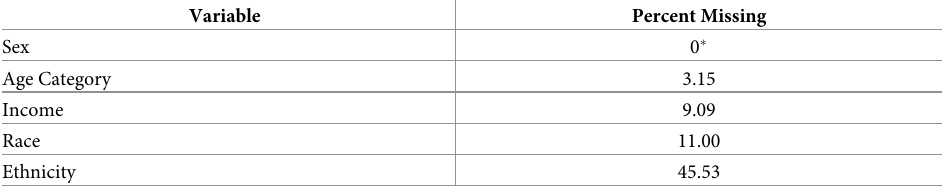
Table 2. Percent of missing values, King County, Washington anti-SARS-CoV-2 seroprevalence survey, August 2020 (n = 1,364).